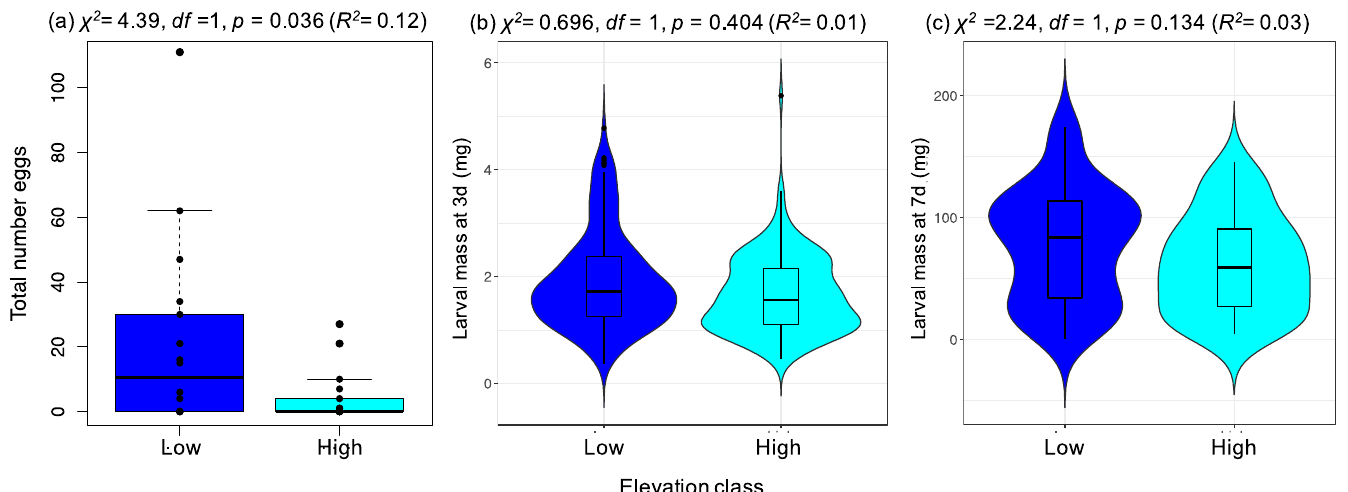
Figure 4. Association between P. brassicae preference and larval performance for Arabidopsis halleri plants from low and high-elevations. ( a ) Boxplot showing variation in female preference (number of eggs laid after 20 h) for the different elevation classes (with individual data points given), and violin plots showing variation in individual larval mass among elevation classes after ( b ) 3 and ( c ) 7 days of feeding. As a result of the large number of data points in ( b , c ), violin plots are presented to indicate the density of observations for particular larval mass values. Within each probability density graph is a boxplot with the dark horizontal line representing the median mass value for that elevation class. For each plot, the significance of the effect of elevation ( x -axis) on the response variable is given using either a negative binomial model ( a ), or linear mixed effects models ( b , c ). Elevation class is represented by two high- and two low-elevation populations.